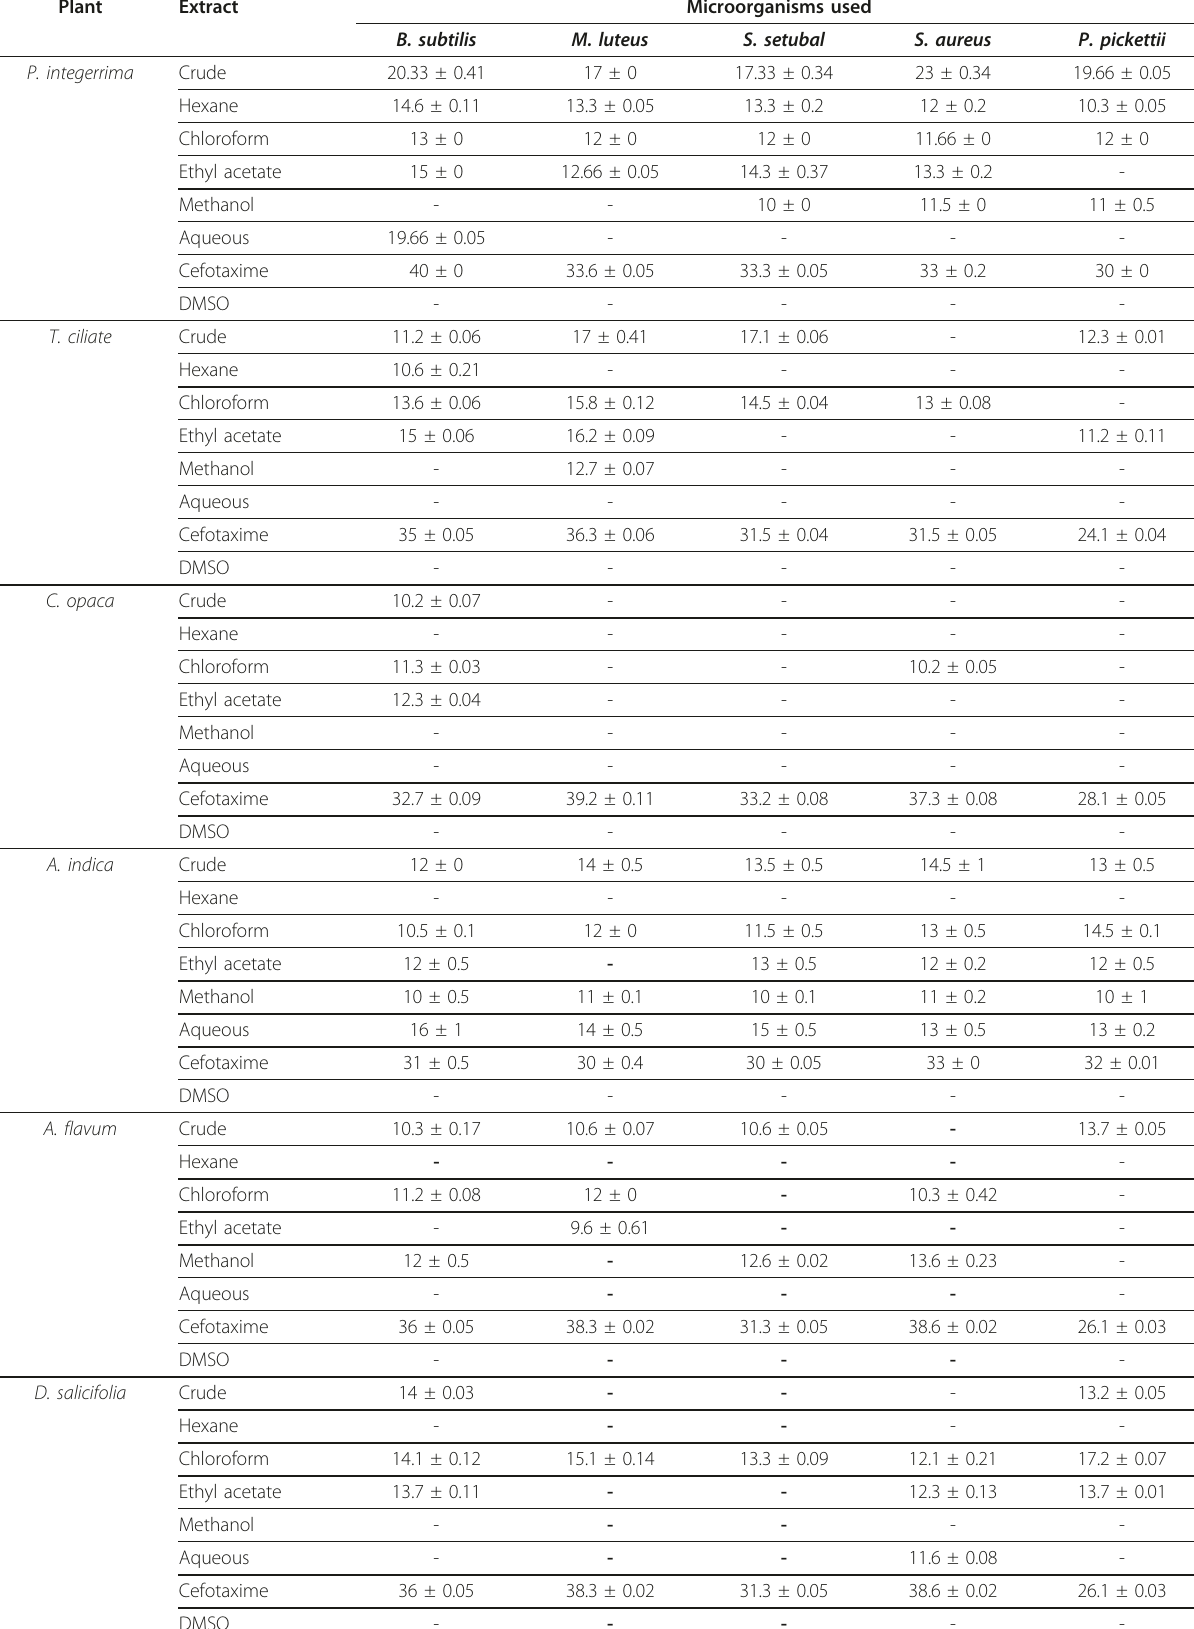
Table 2 Zone of inhibition (mm; in diameter) against different bacterial strains by plants extracts